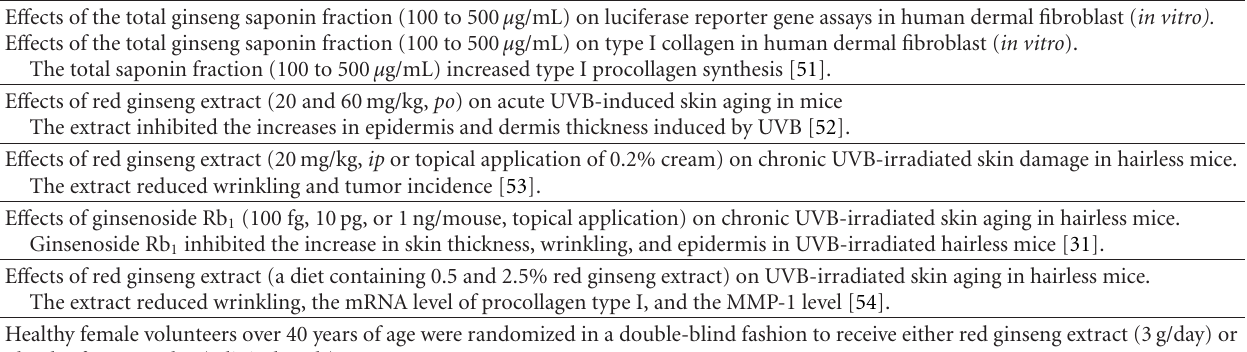
Table 3: E ff ects of Panax ginseng extract on skin